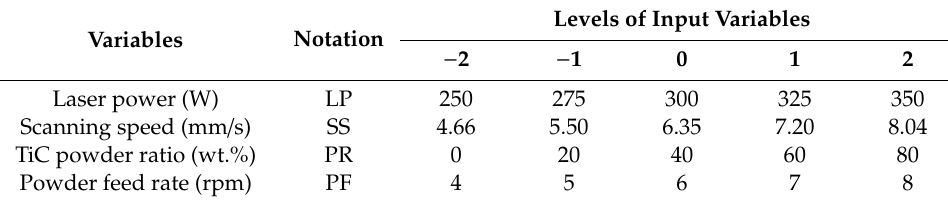
Table 3. The LENS process parameter